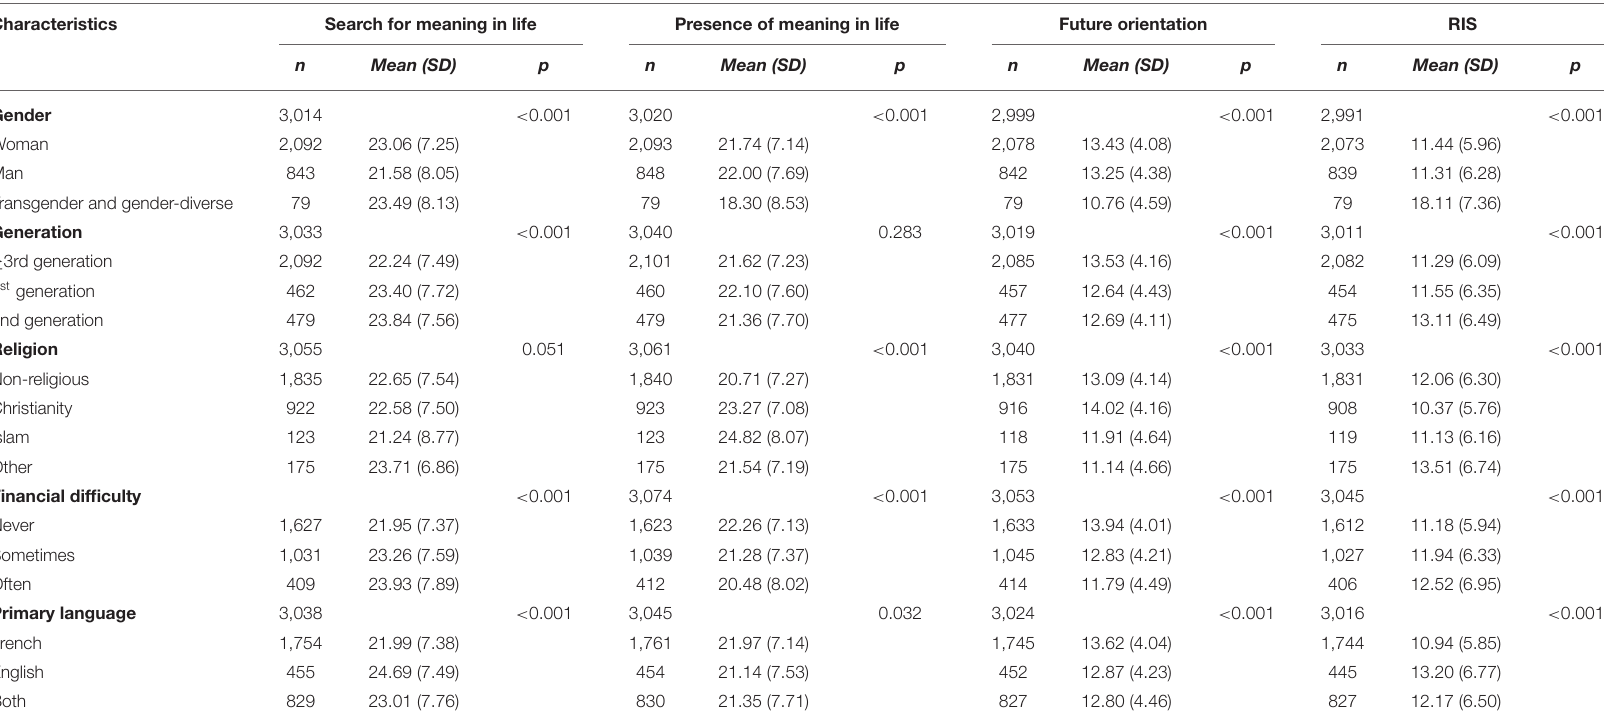
TABLE 3 | Socio-demographic characteristics of participants and descriptive statistics of study variables, separately for each socio-demographic category. Characteristics Search for meaning in life Presence of meaning in life Future orientation